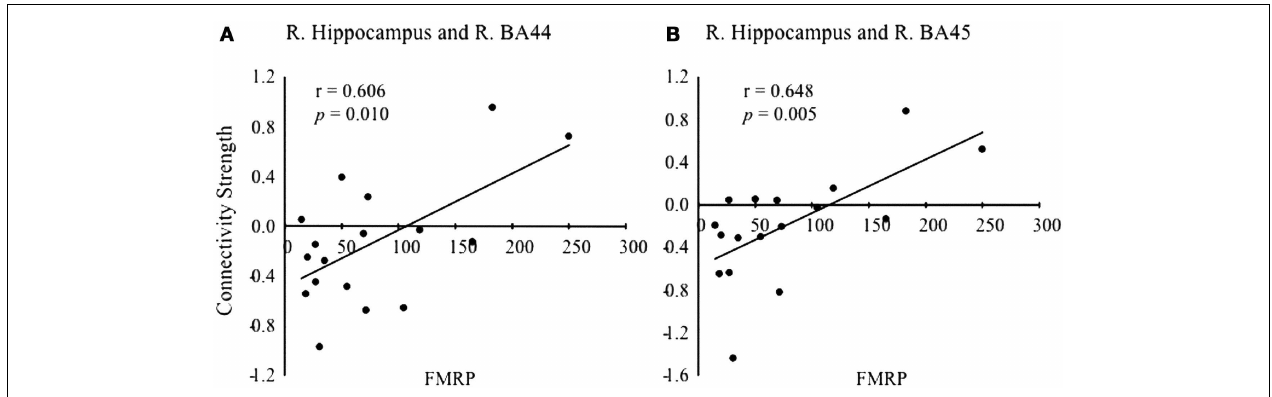
FIGURE 5 | Scatter plot showing the correlation between fragile X mental retardation protein (FMRP) levels and the strength of connectivity between the right hippocampus with right BA44 (A) and right BA45 (B) of